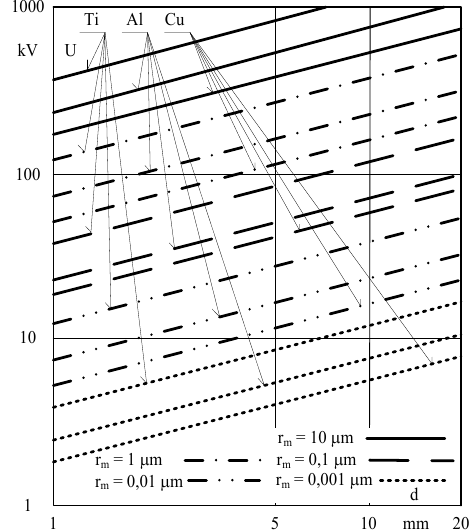
Fig. 2. Dependence of the minimum voltage value, causing in the insulation systems with electrodes made of Cu, Al or Ti, acceleration of spherical microparticles, with a radius r m equal to 0.001, 0.01, 0.1, 1 and 10 μm, to the velocity causing plastic deformation of the electrode surface in which they hit, from the length of the electrode